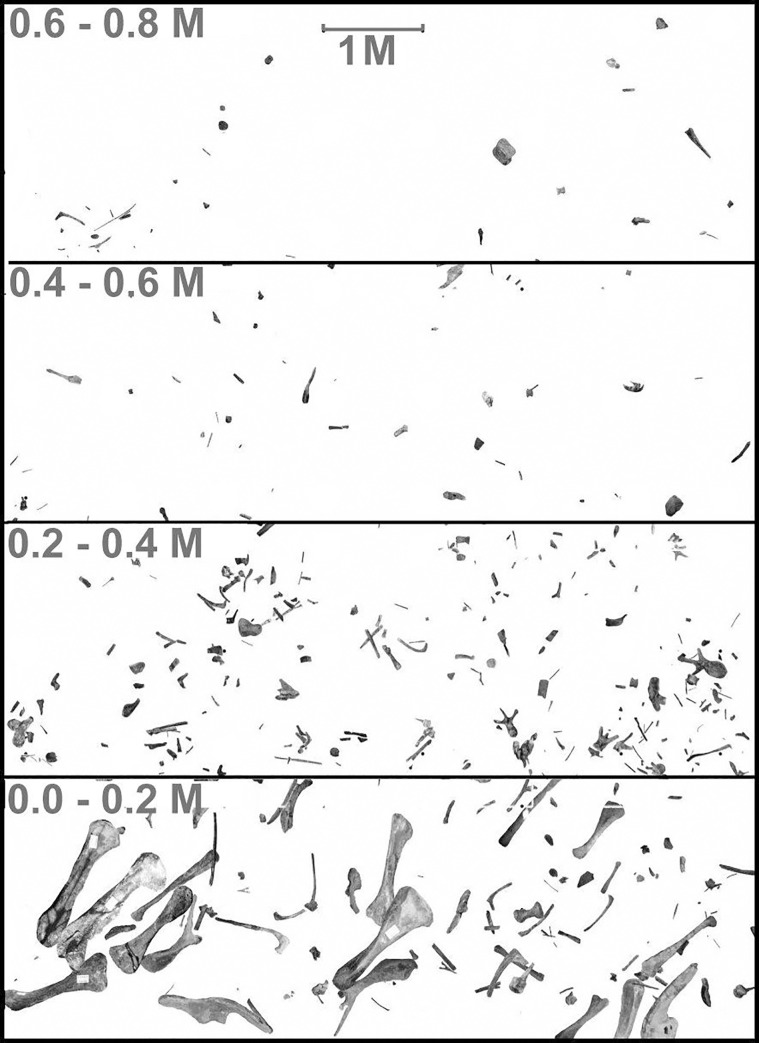
Plan view of bone distribution in successive 20 cm deep intervals at north quarry.Bar is one meter long. Stratigraphic height starts with “0.0” at the bottom.